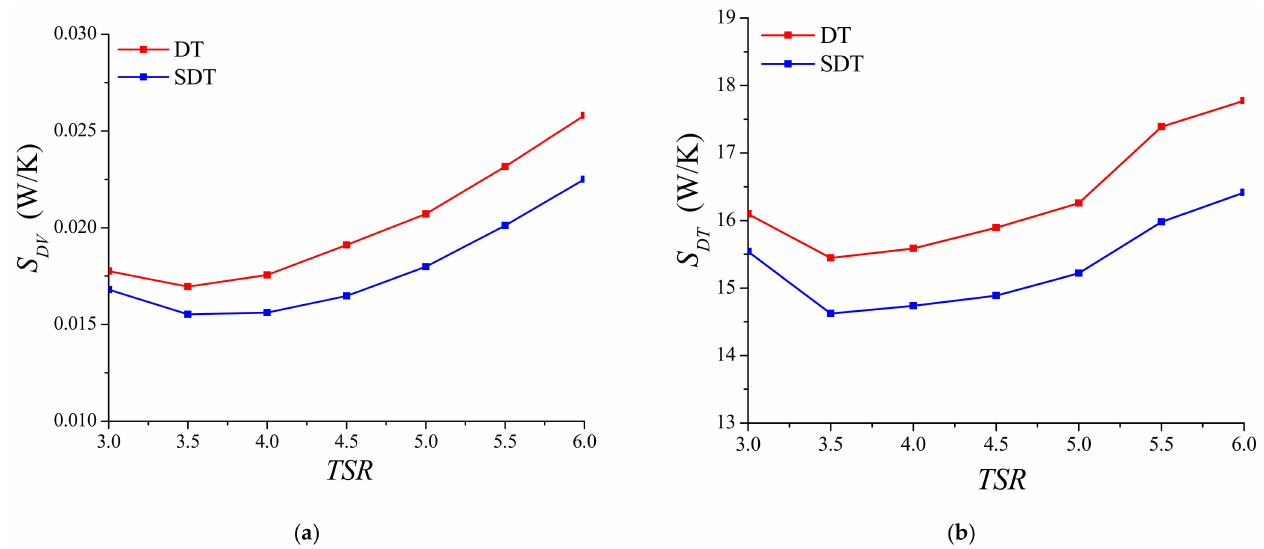
Figure 11. Entropy production comparison between the DT and the SDT: ( a ) viscous dissipation entropy production; ( b ) turbulent dissipation entropy